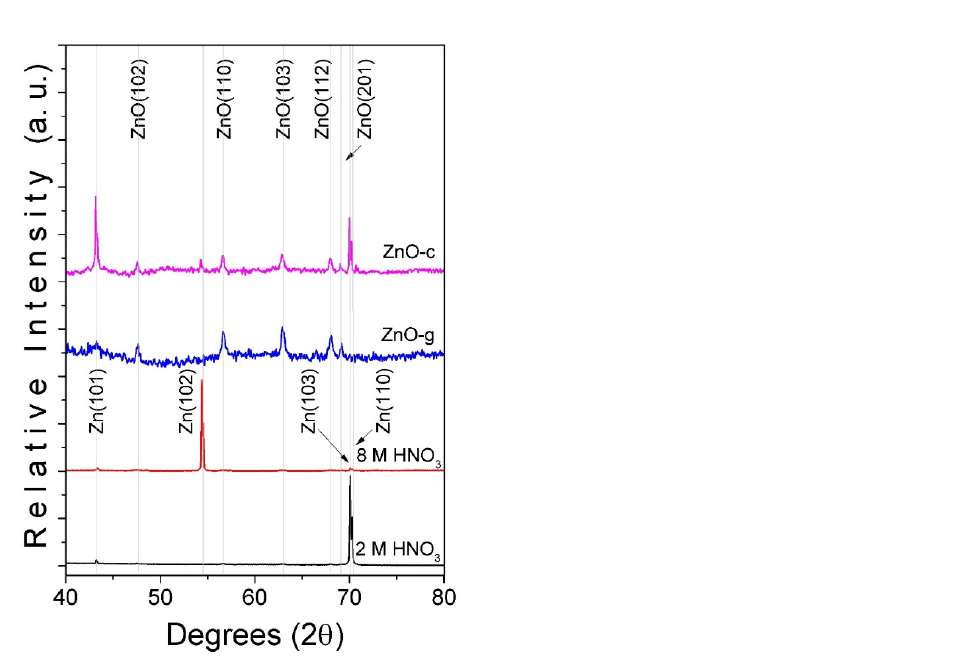
Figure 1. Comparison between XRD patterns of Zn foil etched with HNO 3 (2 and 8 M concentration) before and after TO at 500 °C. Note that samples obtained after TO for 2 and 8 M were the grass-like (ZnO-g) and cane-like (ZnO-c) ZnO nanostructures.